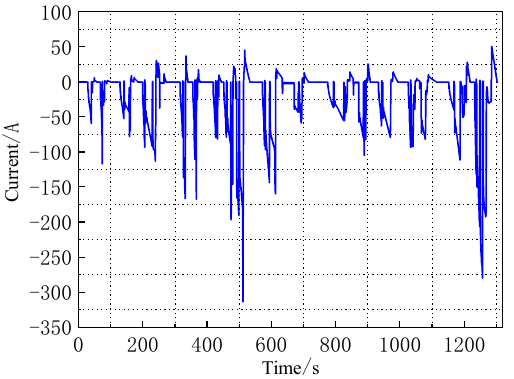
Figure 13. Current when battery is powered alone.